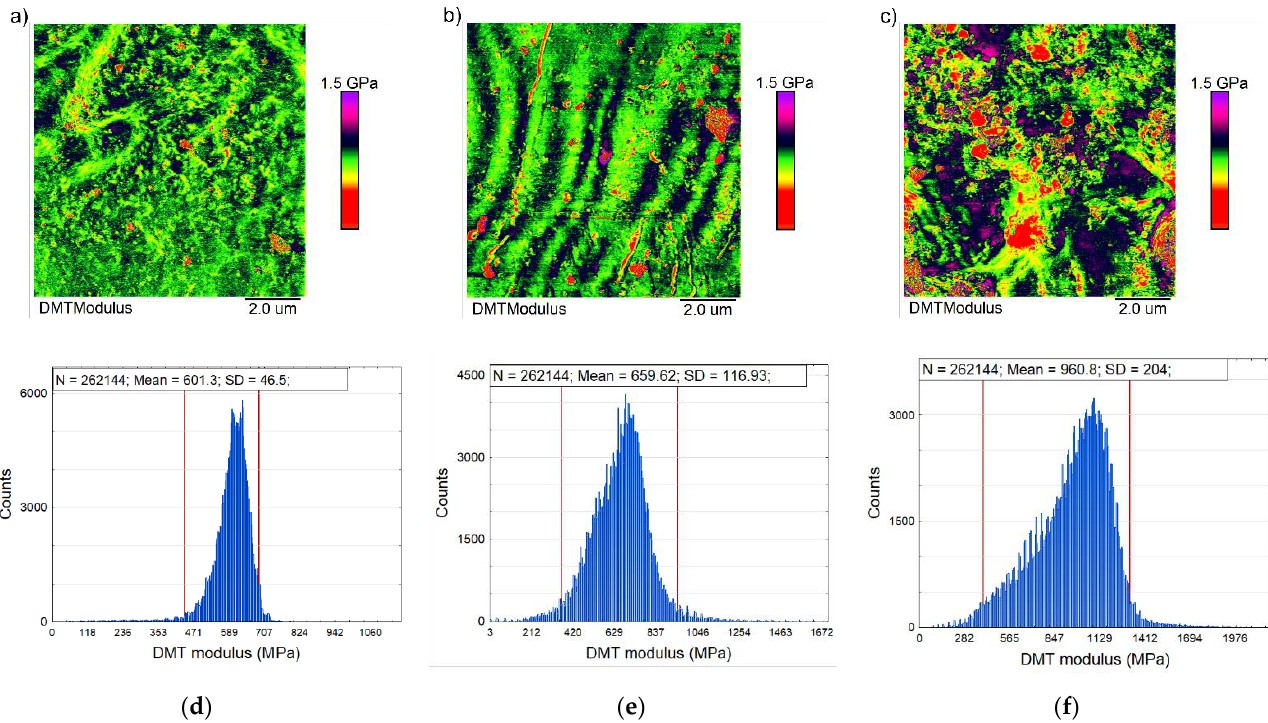
Figure 5. Representative map of the DMT moduli (10 × 10 μm) for samples k0 ( a ), k5 ( b ), k10 ( c ), and the corresponding histogram ( d – f ) of the distribution of the DMT moduli. The red line superimposed on the frequency histograms represents the 95% range of the measured values.